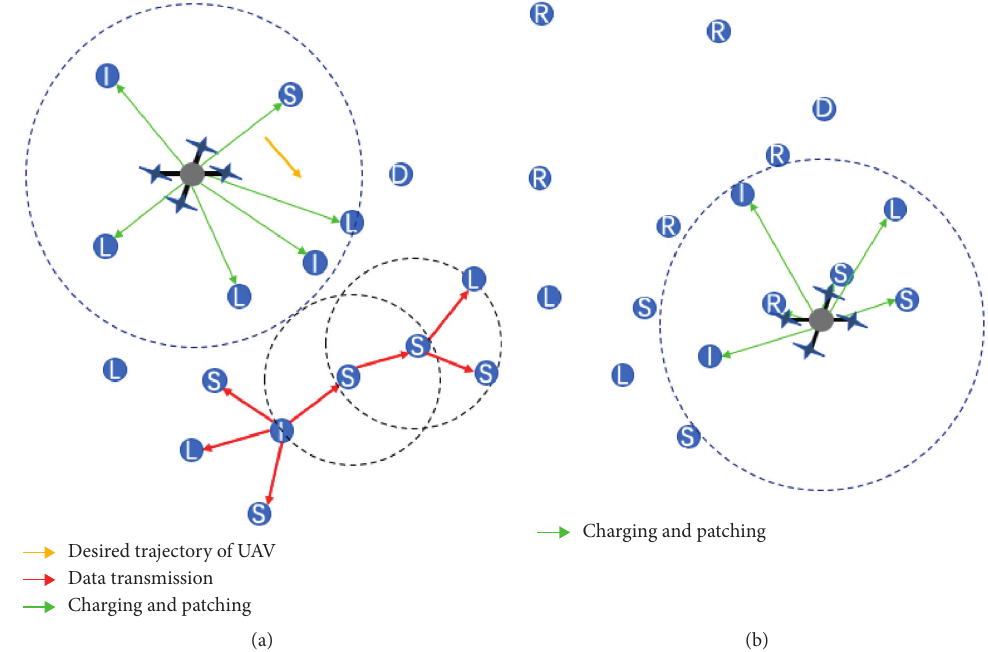
Figure 1: Evolution of nodal states in UAV coverage area. (a) The location of the UAV at a certain moment and the nodal states before UAV moves. (b) The evolution of Nodal states as a result of the UAV moving with the desired trajectory from the original position.